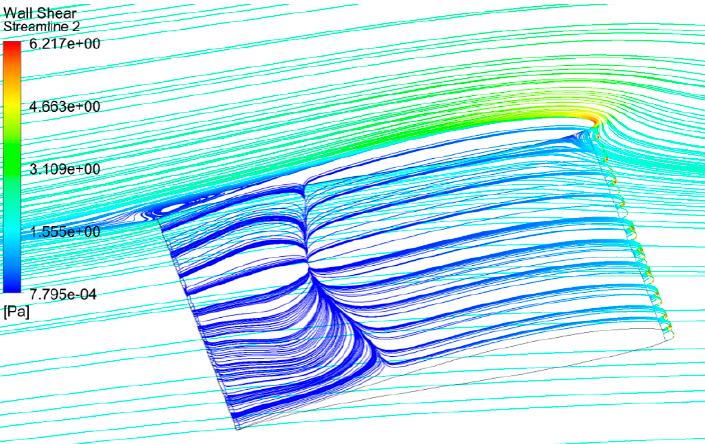
Figure 25. 3-D flow on the surface of polyimide-skin wing ( v = 6.4 m/s, α = 4°).